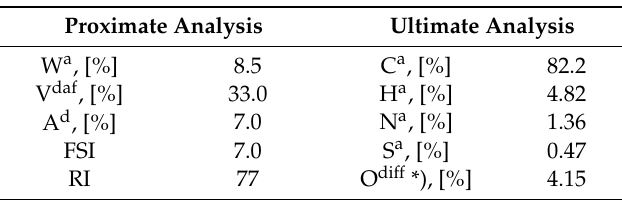
Table 1. The main characteristics of